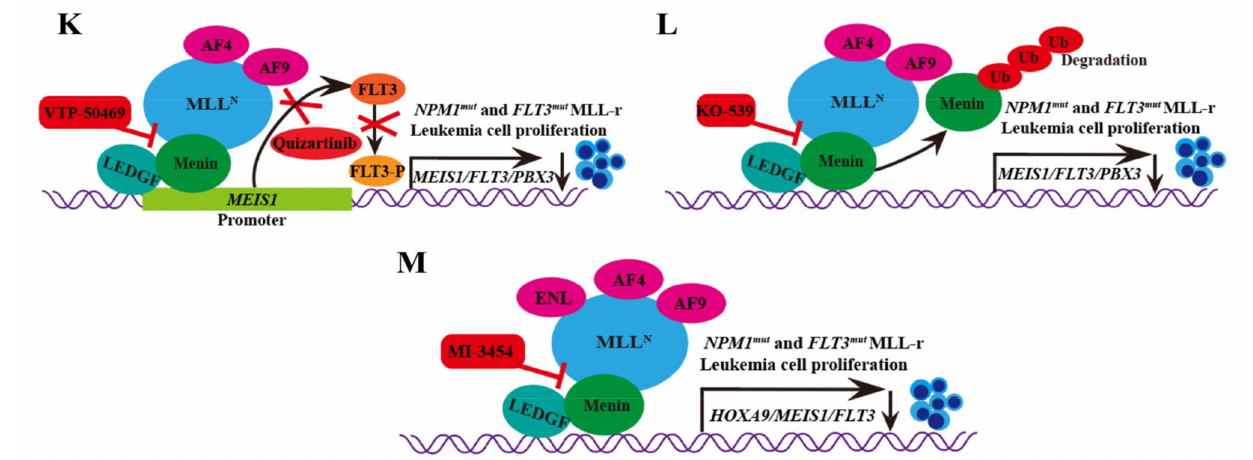
Figure 2. Molecular mechanisms of thiophenpyrimidine inhibitors in treating leukemia and cancers. ( A ) The interaction between menin and MLL-AF4, MLL-AF9, and MLL-ENL fusion proteins is blocked by MI-2 and MI-3 inhibitors to reduce the transcription of HOXA9 and MEIS1 genes, which is accompanied by the reduction of H3K4 trimethylation and H3K79 dimethylation and inhibit the MLL-r leukemia cell growth. ( B ) MI-2 blocks the menin − MLL interaction combined with β -catenin inhibitor ICG-001 to reduce the expression of H3K4me3 in the Wnt signaling pathway target genes Axin2 , Id2 , Tcf7l2 , thereby inhibiting the proliferation of salivate gland and head and neck tumor cells. ( C ) MI-3 blocks the menin − MLL interaction and decreases the Rasgrf1 expression. The